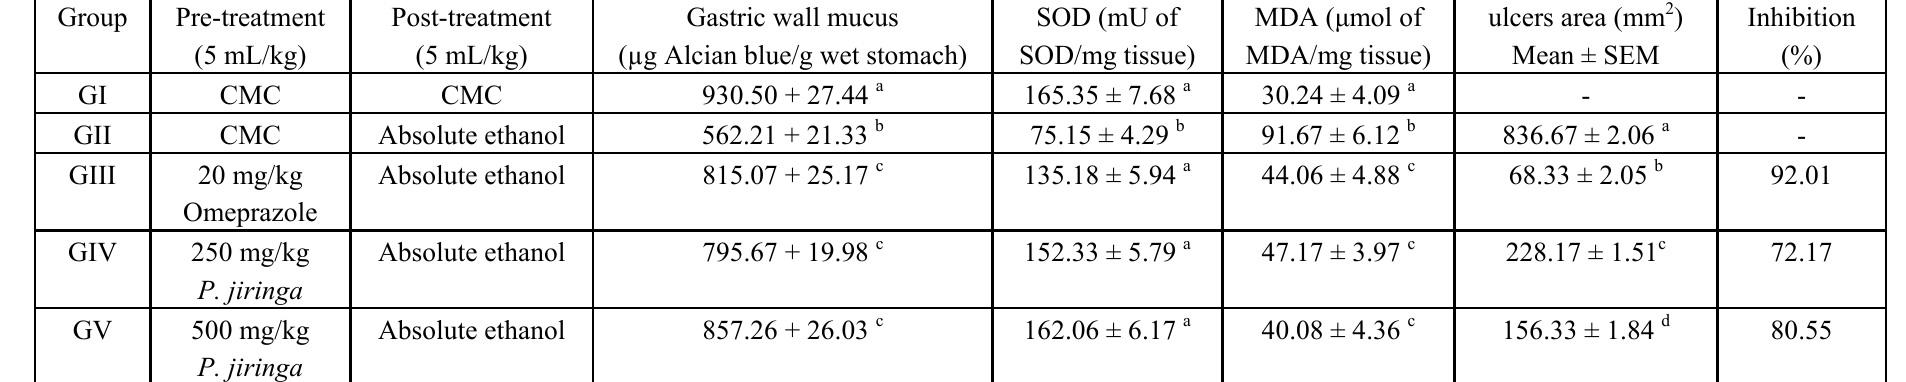
Table 3. Effect of P. jiringa on ethanol-induced changes in gastric wall mucus, Superoxide dismutase, Lipid peroxidation and ulcers area in